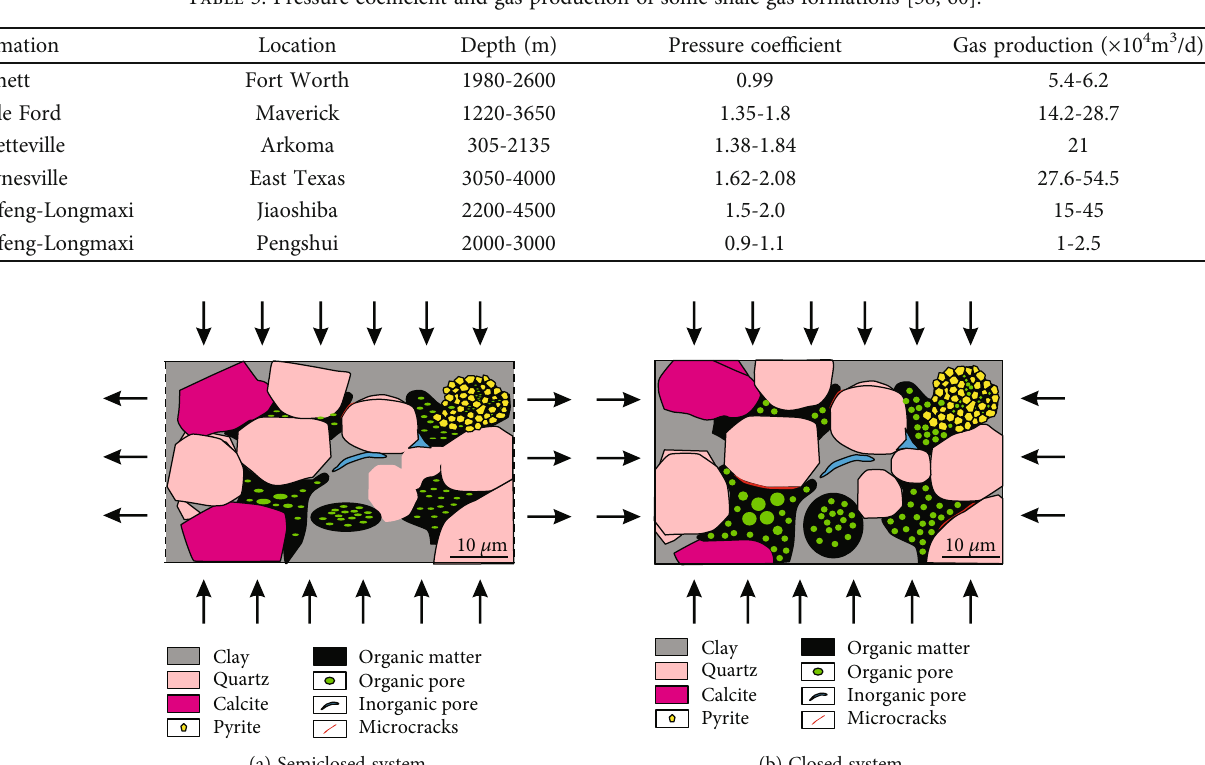
Table 5: Pressure coe ffi cient and gas production of some shale gas formations [58, 60].